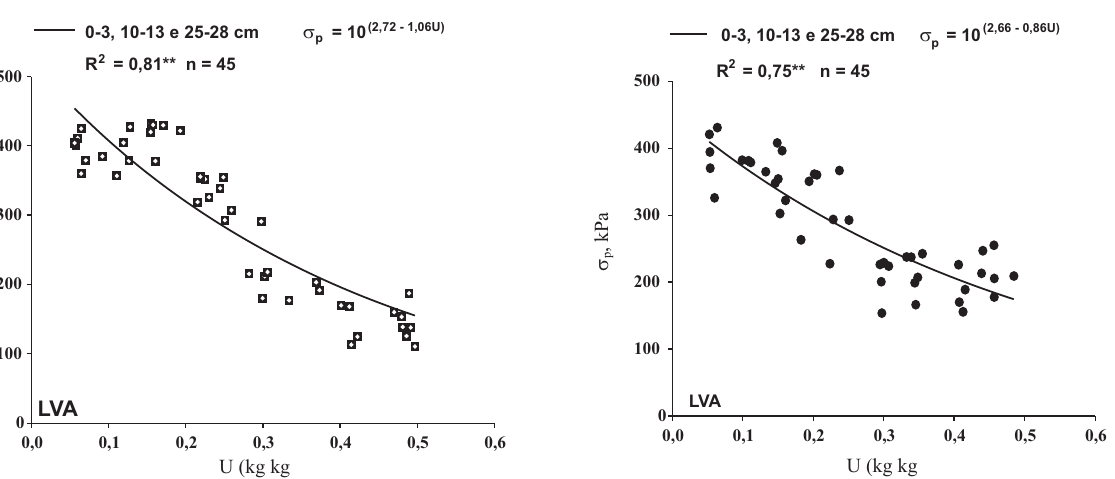
Figura 1. Modelo de capacidade de suporte de carga (CSC) para o sistema de manejo sem capina (SC) no centro da entrelinha, para as camadas de 0–3, 10–13 e 25–28 cm. U: umidade, σσ σσσ de preconsolidação.